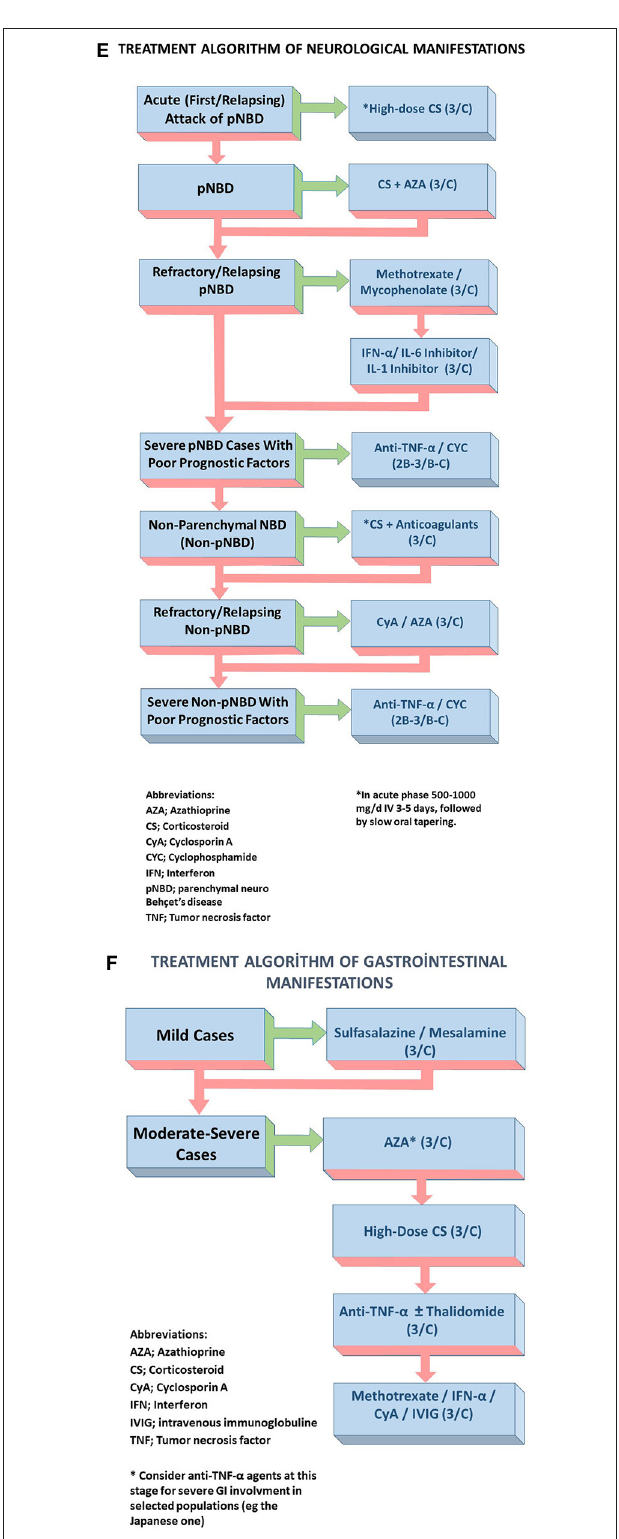
FIGURE 1 | Treatment algorithms of mucocutaneous (A) , articular (B) , ocular (C) , vascular (D) , neurologic (E) and gastrointestinal (F) symptoms. In the flow charts all treatments were placed one under the other in the right columns. Algorithms start from the boxes in the upper left corner. The green arrow means “yes,” the red arrow means